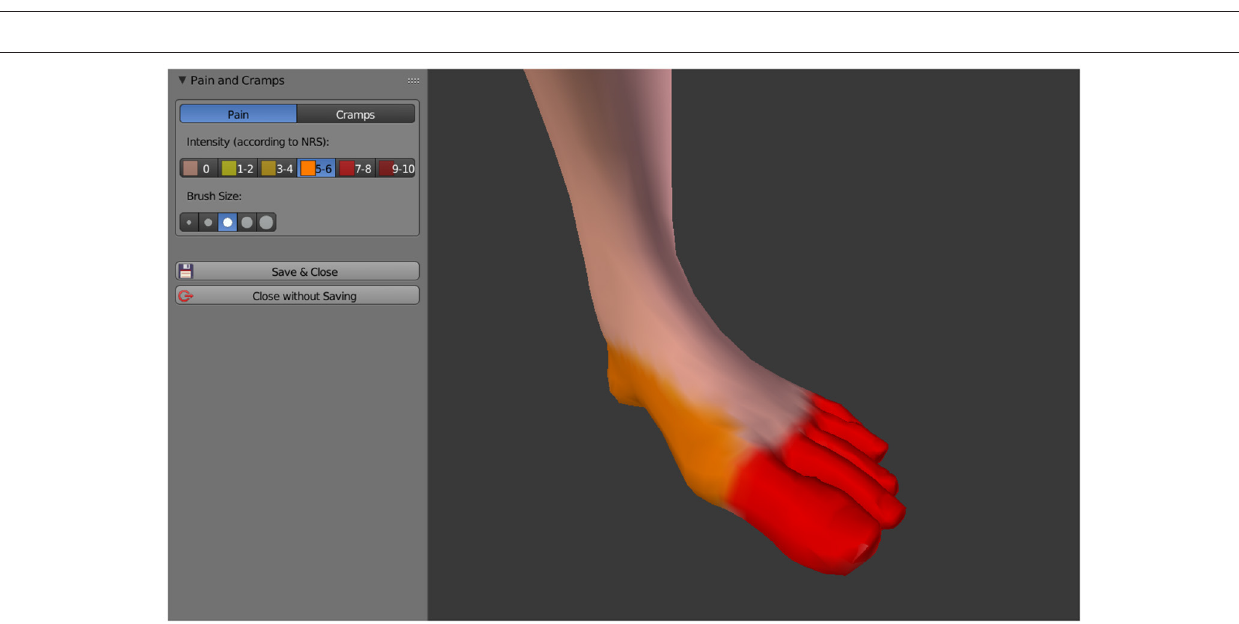
FIGURE 2 | Adjusting the position of the phantom limb by rotating the respective joint axes.